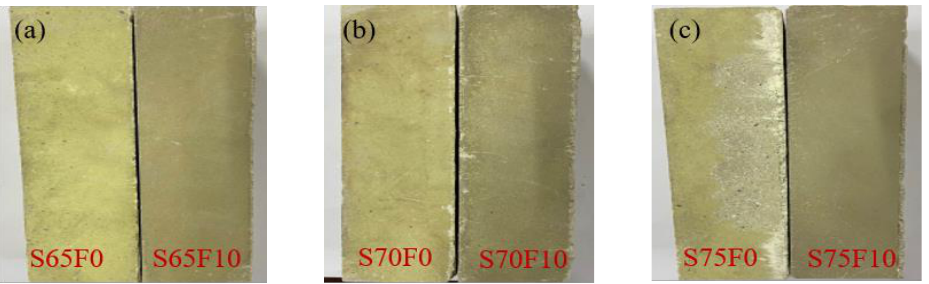
Figure 9. Influence of 0% and 10% fly ash on the appearance of specimens ( a ) S65F0 and S65F10; ( b ) S70F0 and S70F10; ( c ) S75F0 and S75F10.